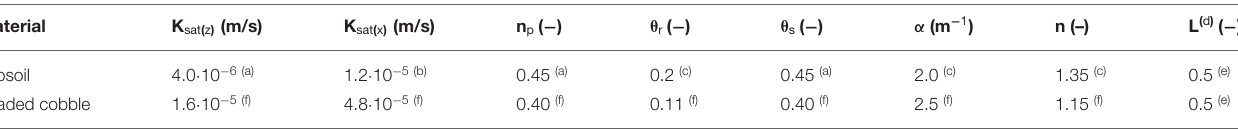
TABLE 1 | Porous media physical